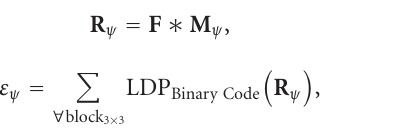
Algorithm 1 expresses the process of syllable extraction when phonemes of a signal are